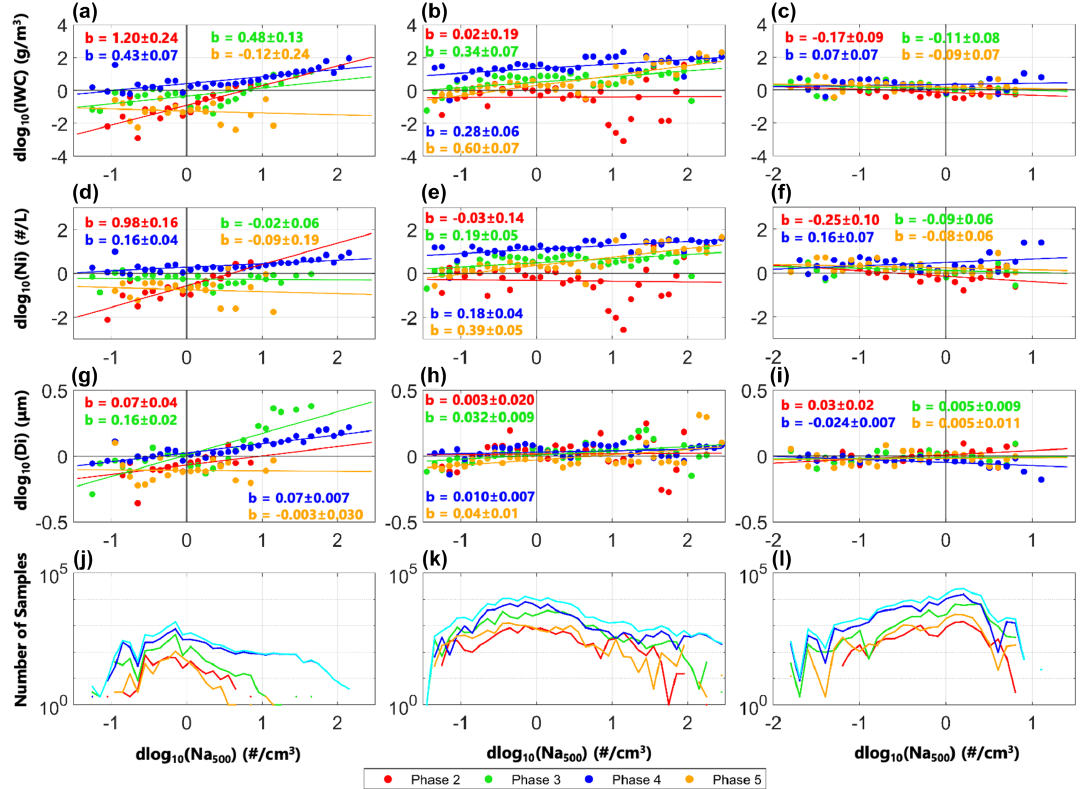
Figure 11. Similar to Fig. 10, except for linear regressions with respect to dlog 10 (Na 500